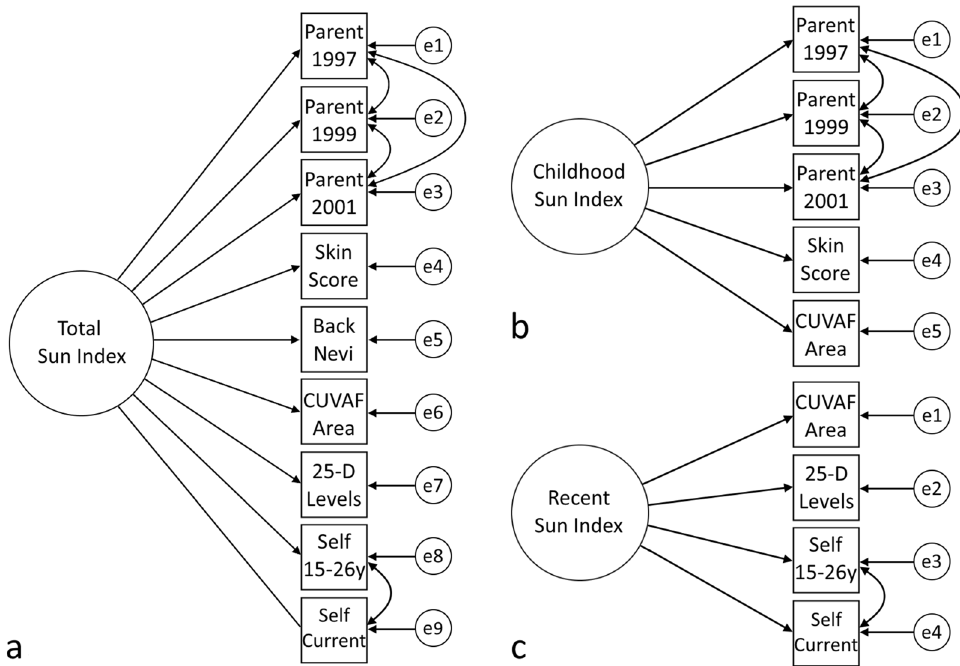
Figure 1. Pathways of the CFA models used to generate factor scores for the total sun exposure index ( a ), childhood sun exposure index ( b ) and recent sun exposure index ( c ). Double-headed arrows indicate covariance terms; small circles indicate error terms. Parent: Parent-reported time spent outdoors. Self: self-reported time spent outdoors. 25-D 25-hydroxyvitamin D, CUVAF conjunctival ultraviolet autofluorescence, Y years, Back nevi average yearly change in number of nevi on the backs between ages 6–12 years, Skin score skin damage